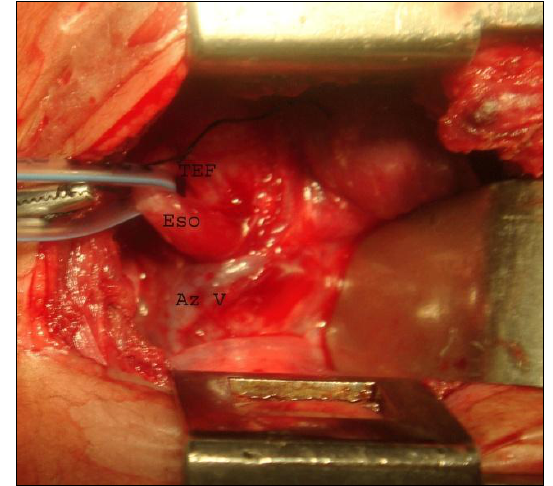
Figure 2: Lower esophageal pouch hooked su- perior to azygos arch with a transfixation su- ture in place at the fistula site.